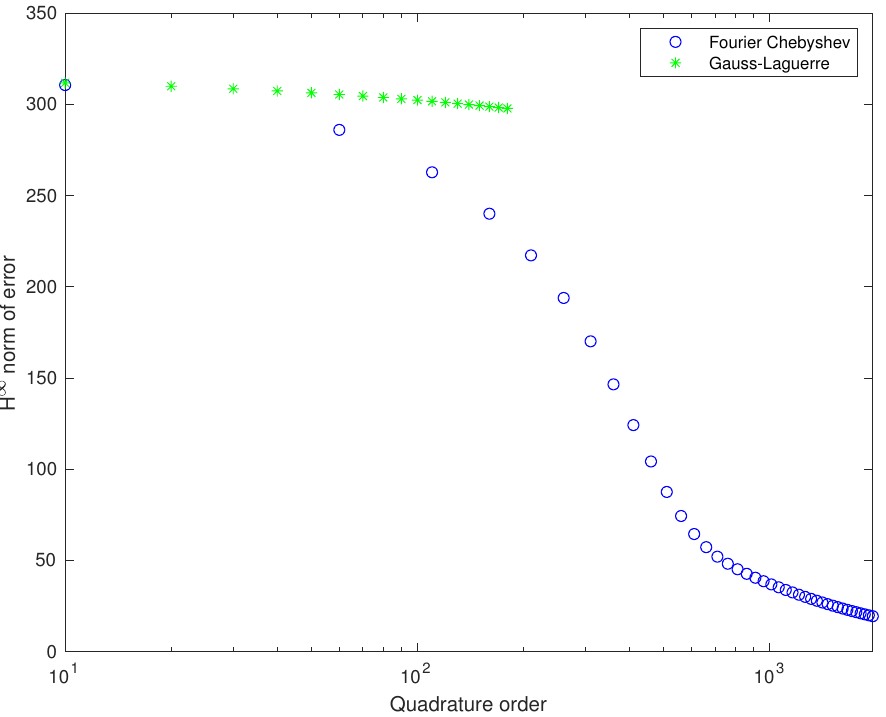
Figure 3. Analysis of (cid:107) e (cid:107) ∞ norm with increasing order of quadrature, for methods defined on unbounded domain. Gauss–Laguerre quadrature rules for order >180 could not be obtained because of ill conditioning of that problem. Convergence of both methods is very